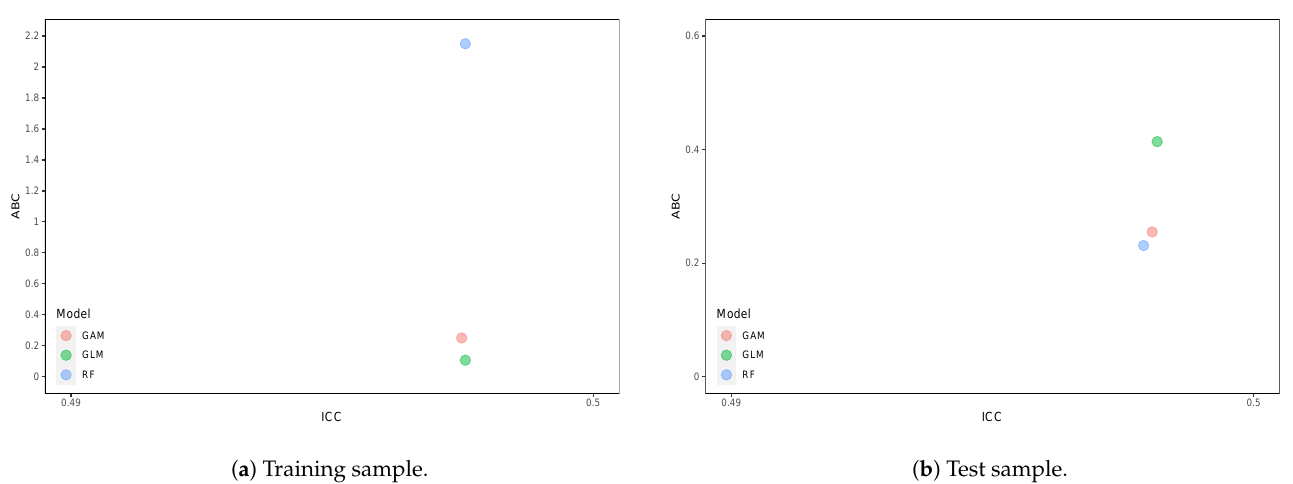
Figure 11. Illustration of the ABC and ICC GOL statistics for log S in the training and test samples.